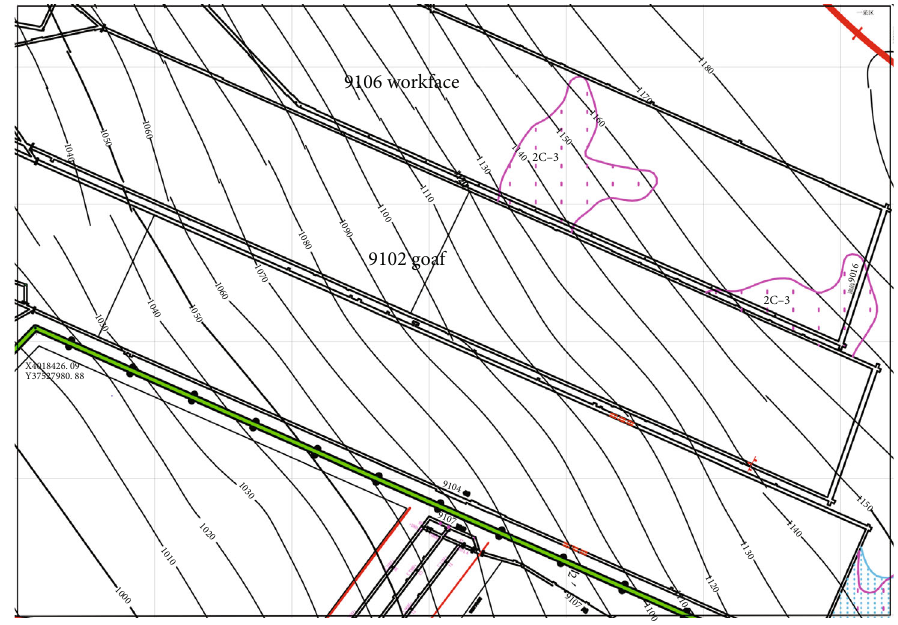
Figure 1: Coal seam mineral component